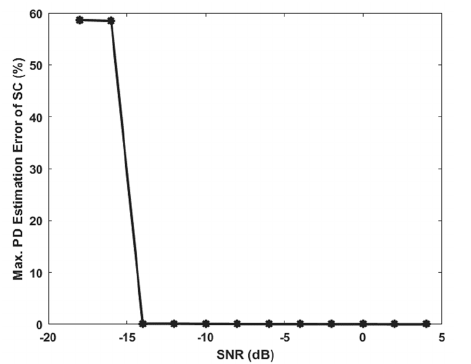
Figure 11. Maximum PD estimation error versus SNR for the SC algorithm.